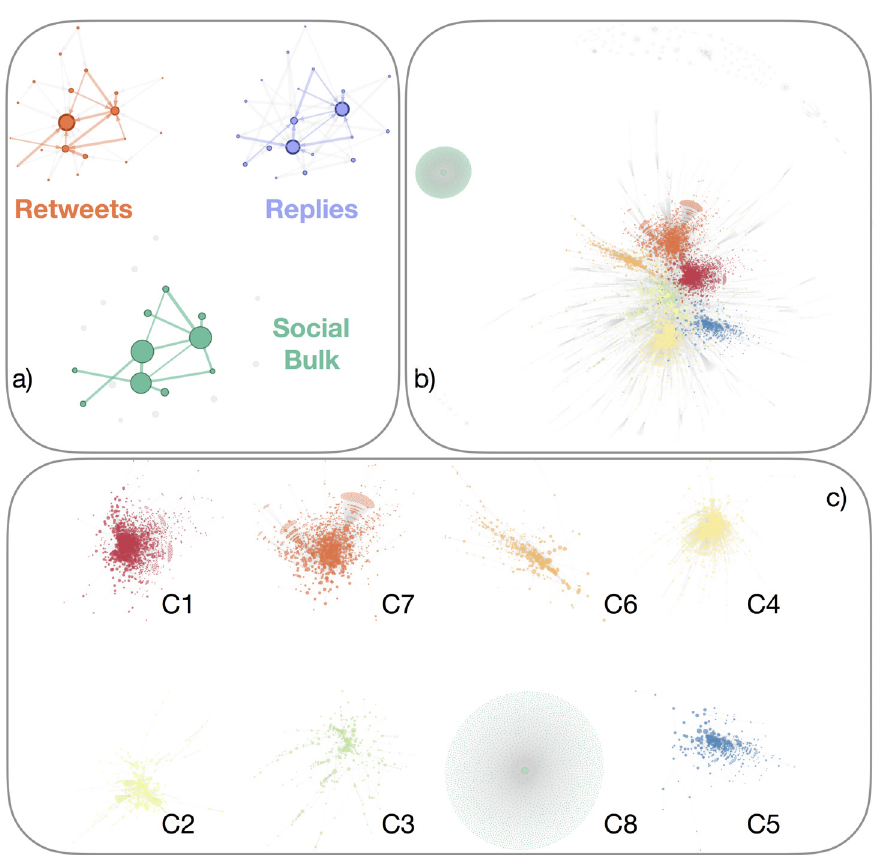
Fig 3. Social bulk of Italian elections. a) Twitter users can retweet or mention or reply with each other. Each action encode a specific social meaning and, by considering the co-existence of endorsement (i.e. retweet) and discussion (i.e. mention or reply), between the same pairs of users, we filter out spurious interactions to identify the social bulk of the system. b) Visualization of the social bulk emerged during Italian elections, with users (i.e., the nodes) colored by the community they belong to (see the text for further detail). c) The eight communities with at least 2% of users are represented separately, while preserving their relative position in the social bulk shown in panel b). Note the remarkable star-like topology C8 characterizing the augmented human identified in the